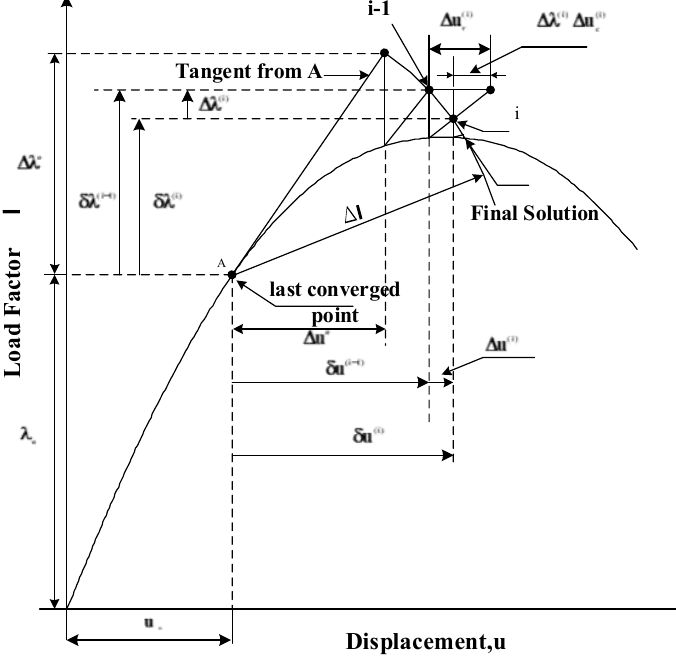
Fig. 5. Crisfield arc-length method (Hellweg and Crisfield,